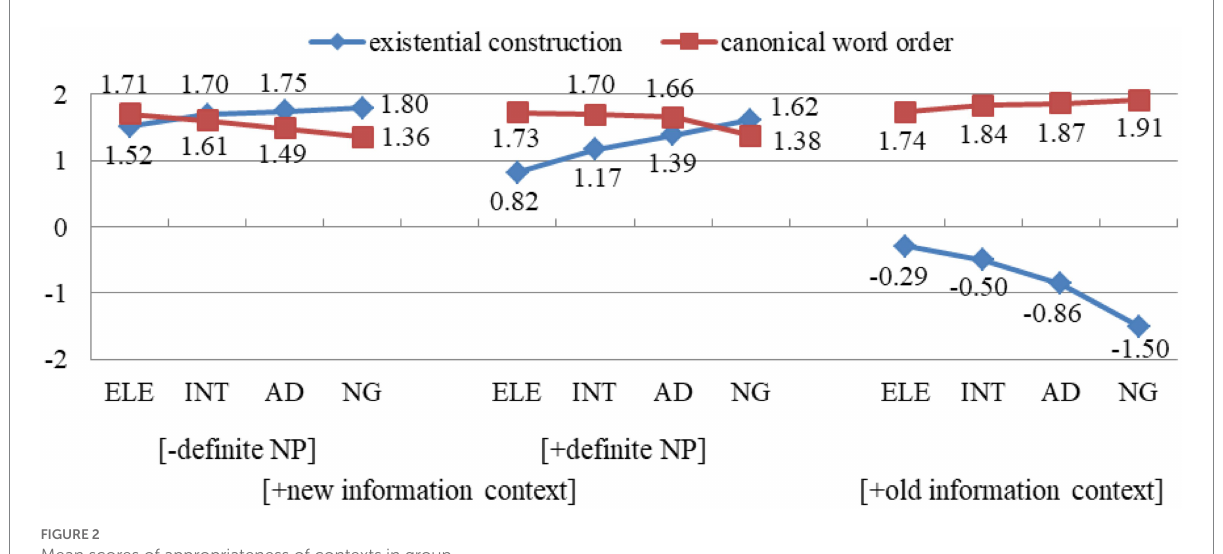
FIGURE 2 Mean scores of appropriateness of contexts in group.